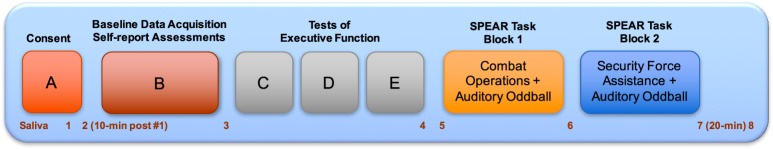
Adaptability protocol. Task events are illustrated and saliva sampling frequency noted. Obtaining the informed consent (A) was followed by completion of self-report assessments, instrumentation and the baseline assessments (B). The Ericksen-Flanker, Iowa Gambling Task, and 2-Back tests of executive function were then administered [(C–E), respectively]. The Soldier Performance and Effective, Adaptable Response (SPEAR) task Combat Operations and Security Force Assistance blocks of trials were then completed (orange and blue boxes). Following each of the tests of executive function and both SPEAR blocks of trials, the participant sat quietly for 2-min for a post-task recovery period. The saliva sample acquisition schedule is noted at the bottom of the figure in red text.